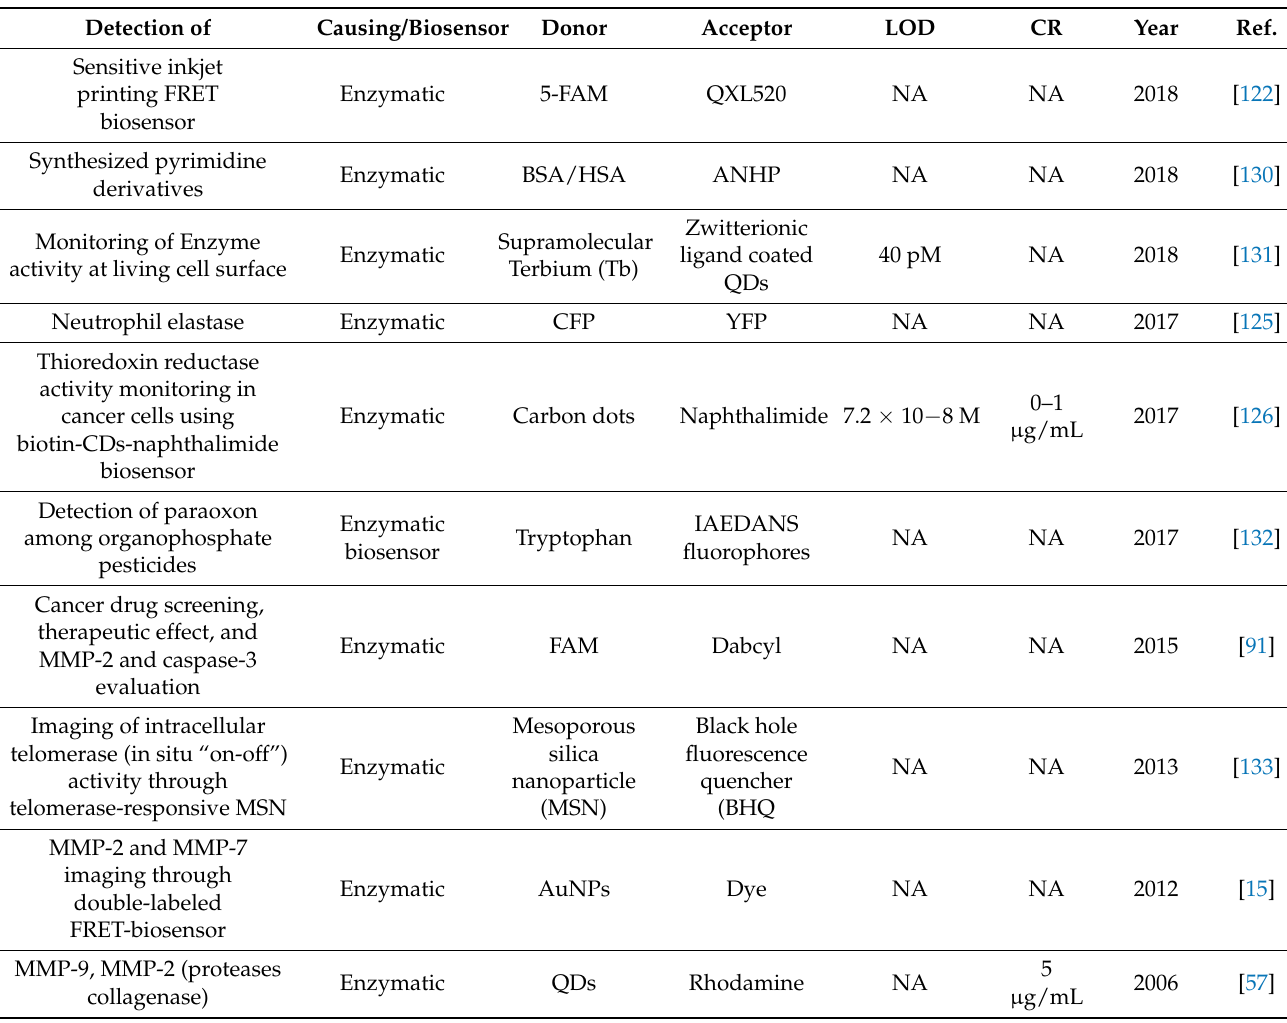
Table 2. FRET-based enzymatic sensors showing donor, acceptor, LOD, CR, and year-wise advance- ment in